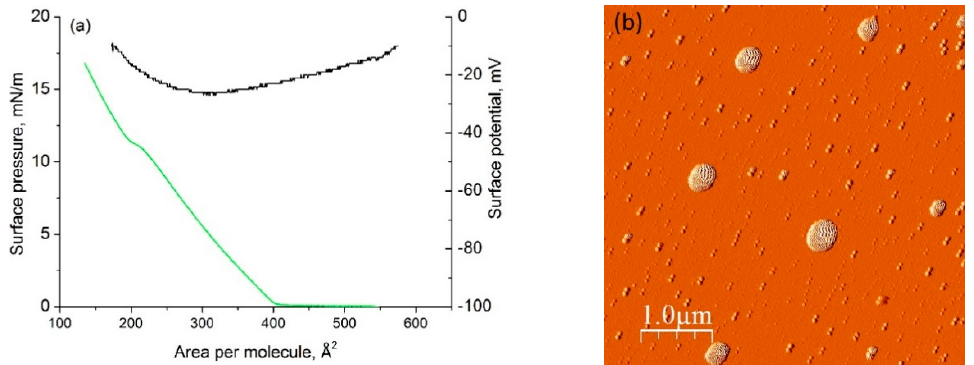
Figure 5. ( a ) Surface pressure-molecular area (green line) and surface potential-molecular area (black line) isotherms of thiacalix[4]arene 2b at the air–water interface ( C = 2 × 10 − 5 M in CHCl 3 :MeOH = 85:15 solvent); ( b ) Atomic force microscopy (AFM) image of five monolayers of 2b on the mica substrate (tapping mode, 5 × 5 µ m).